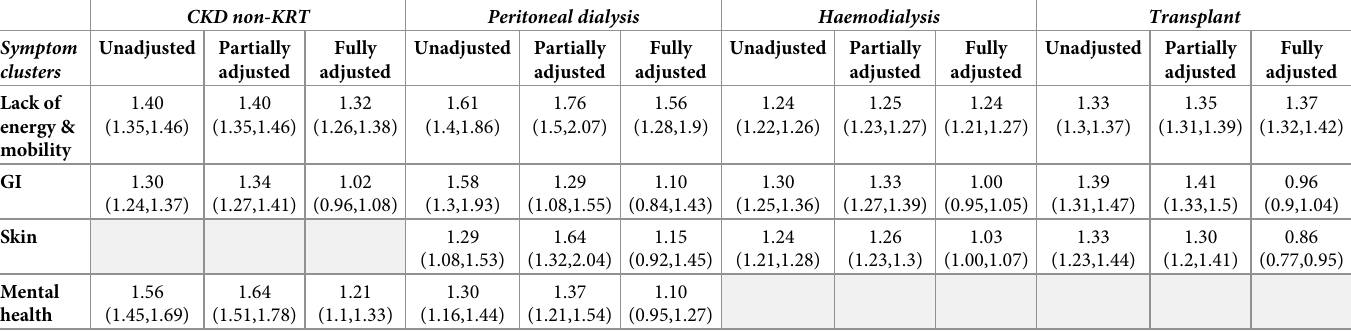
Table 3. Association between total symptom cluster scores and ability to perform usual